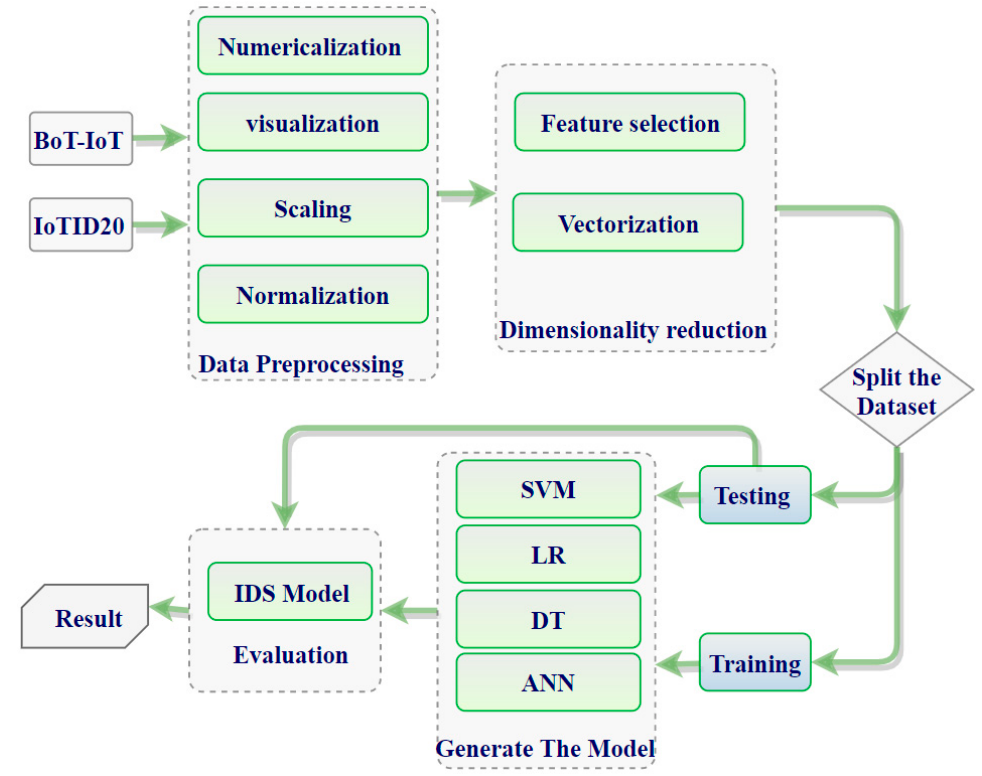
Figure 5. Diagram of our framework of IDS based on the selected ML algorithms.